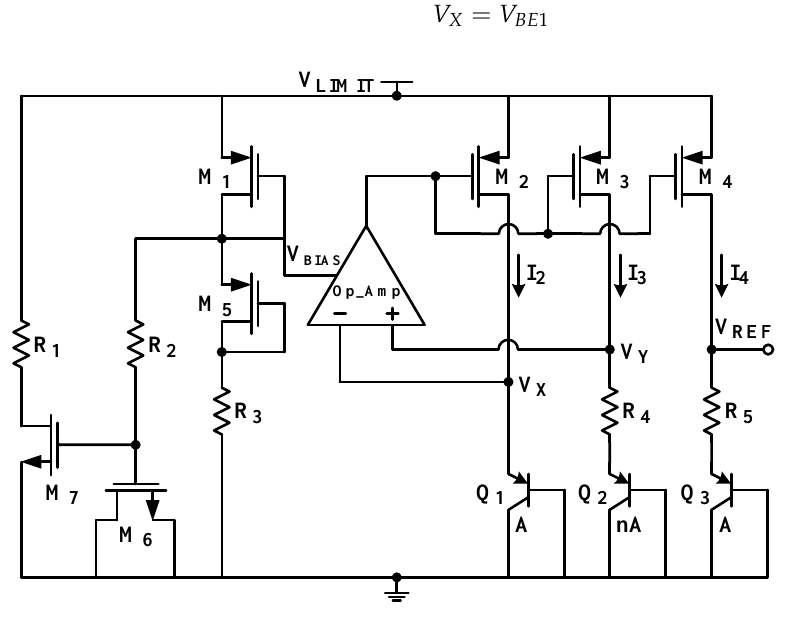
Figure 3. Circuit diagram of the proposed bandgap reference (BGR) in the